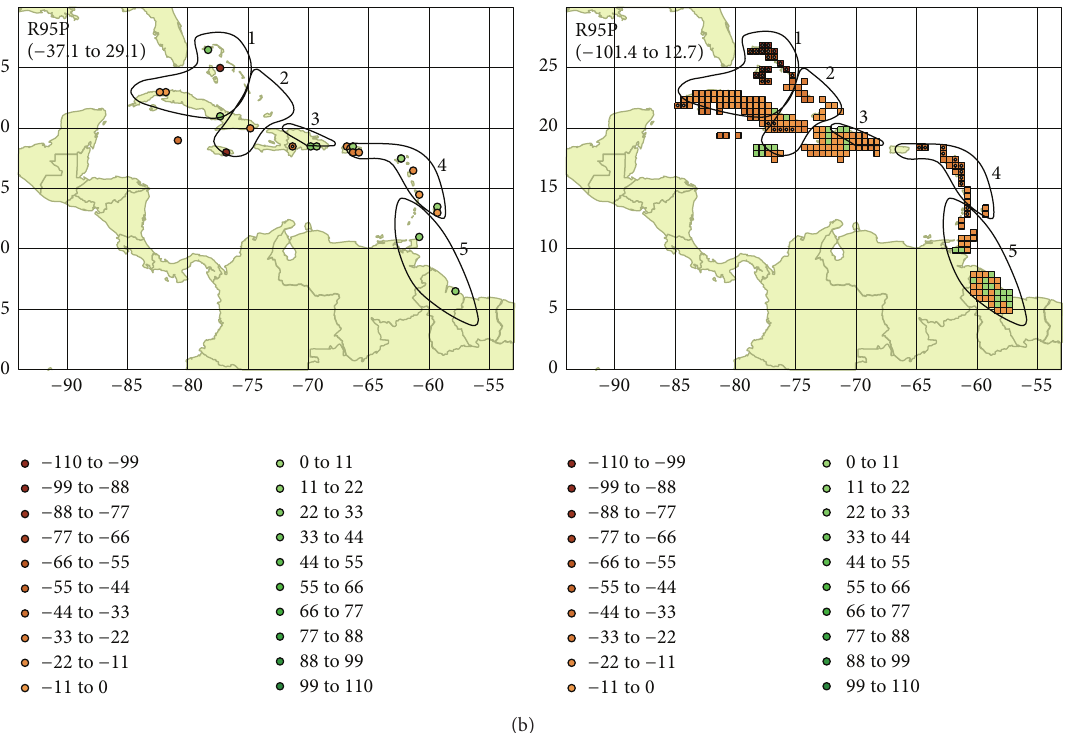
Figure 3: The same as Figure 2 but for extreme rainfall (R95P). Units are mm/year. Statistically significant trends are indicated with white